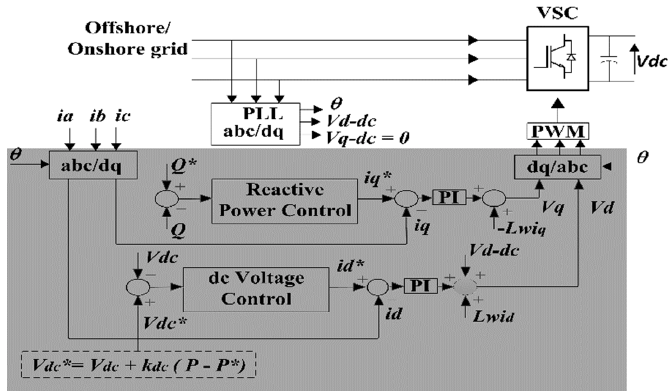
Figure 1. The dc voltage droop control using the d-q reference frame.